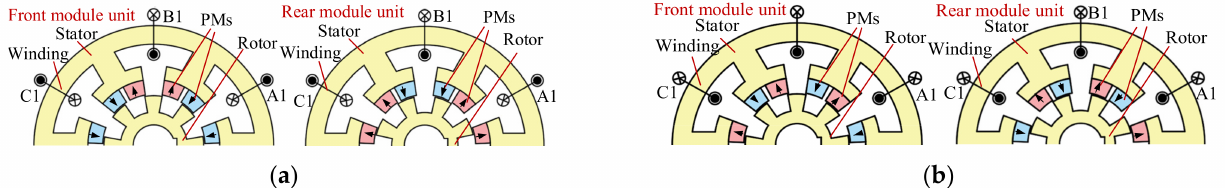
Figure 2. Axial modular structures of AM-FRPM machines. ( a ) AMA-FRPM topology. ( b ) AMC- FRPM topology.